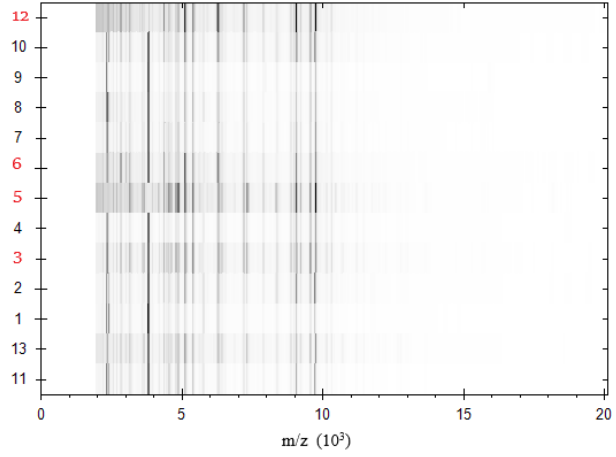
Figure 4. Virtual gel analysis using the MALDI BioTyper 3 ′ s special tool reveals changes in band pattern. The m/z values are represented on the x axis, and the obtained mass spectra of the tested E. coli isolates are represented on the y axis. The protein expression profile peaks produced by MS are seen for isolates. Non-related isolates are illustrated by red labels.